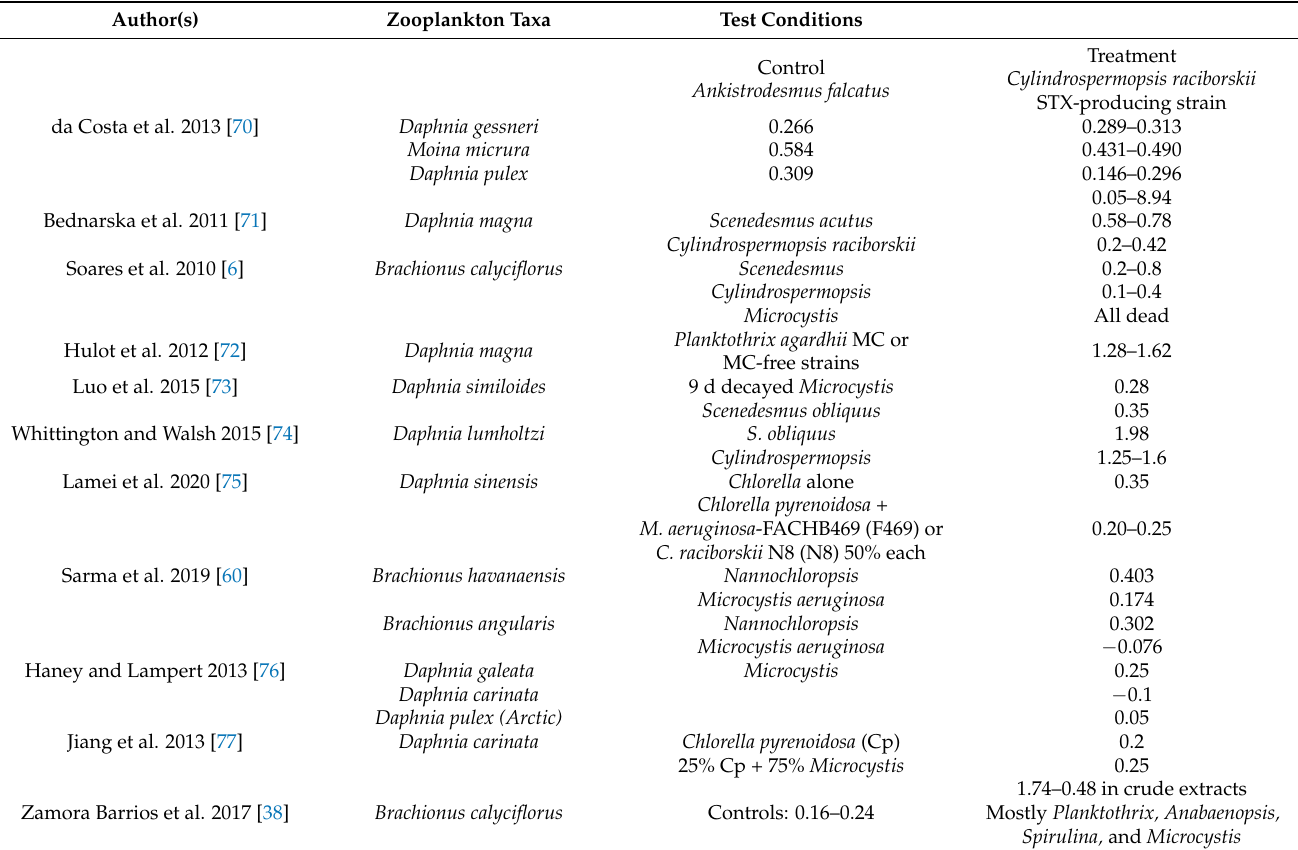
Table 4. Population growth rates of zooplankton cultured on cyanobacterial